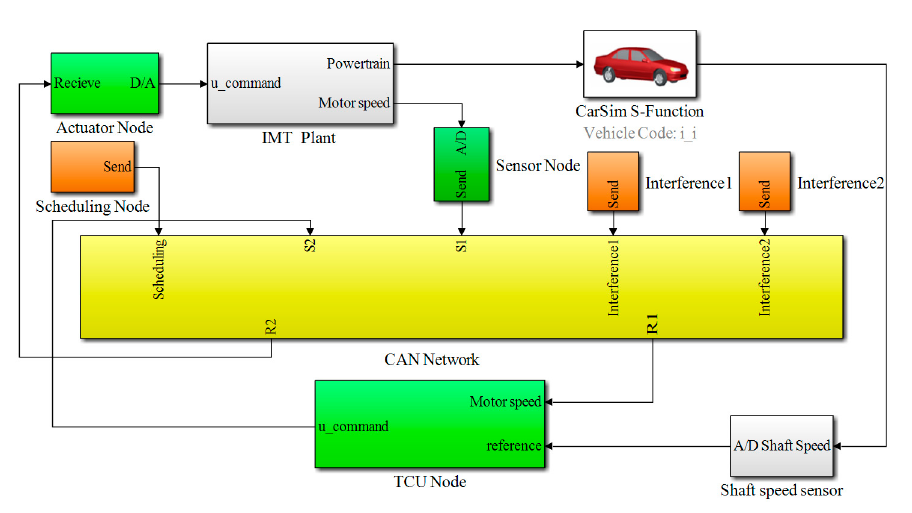
Figure 6. Co-simulation diagram. Table 1. Parameters for simulation.